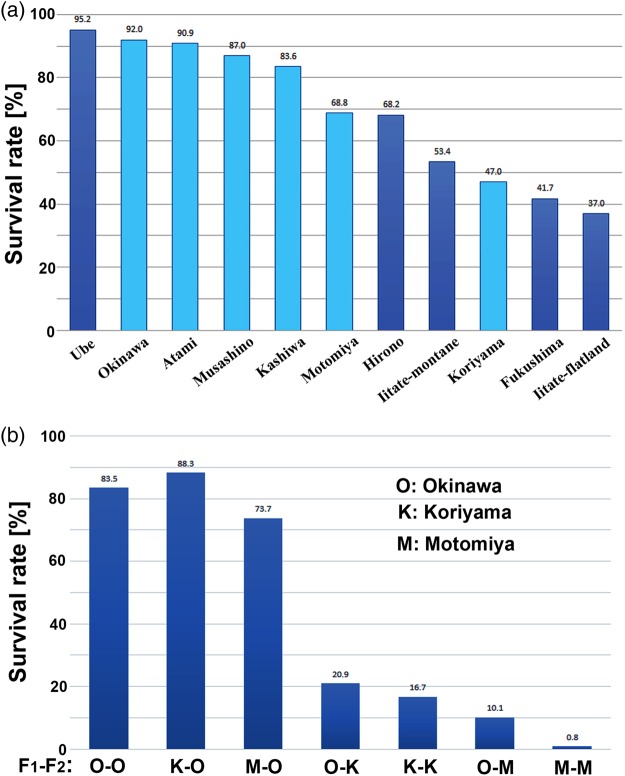
Survival rate (percentage survival) of the internal exposure experiments. (a) The effects on the first generation, which include relatively high contamination levels [34] (the first set of experiments, shown in dark blue bars) and relatively low contamination levels [38] (the second set of experiments, shown in light blue bars). (b) The effects on the second generation [38]. For example, ‘O-K’ indicates that leaves from Okinawa were given in the first generation (defined as F1) and leaves from Koriyama were given in the second generation (defined as F2).